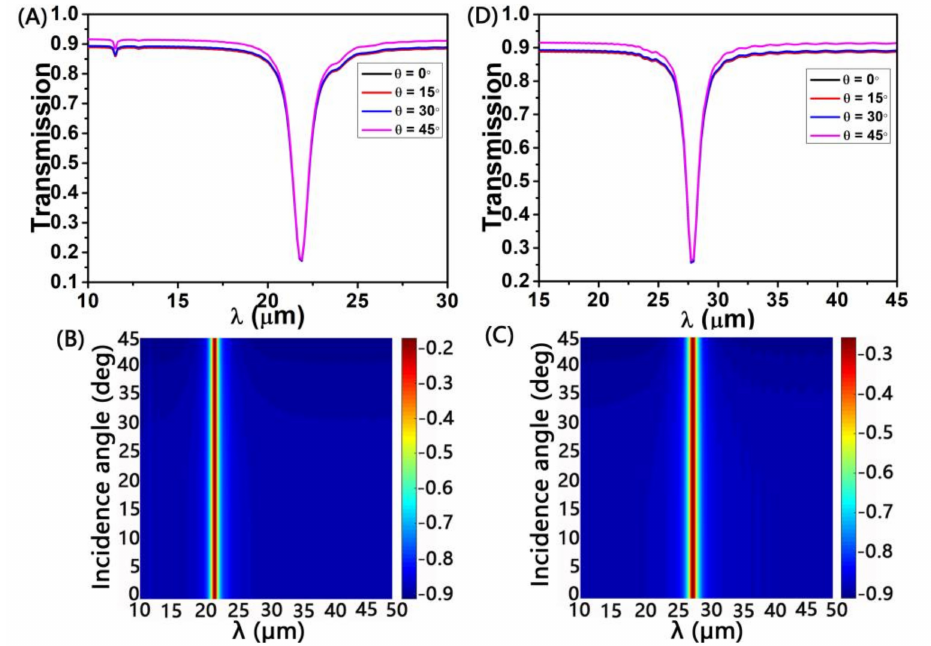
Figure 6. The transmission spectra at different angles of incidence, for TM ( A ) and TE ( B ) polarizations, respectively. The simulated angle dispersions of the transmission in graphene nanoring-strip with the doping level of n g = 3 × 10 13 cm − 2 for ( C ) TM and ( D )